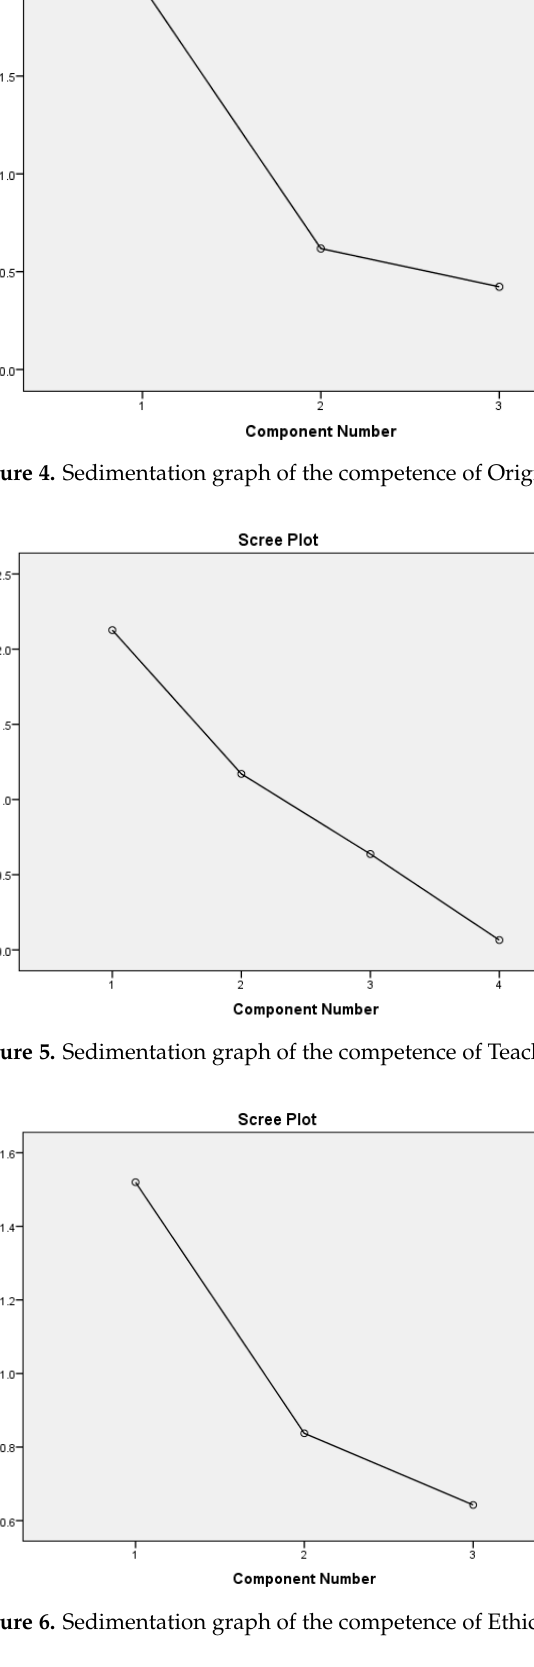
Figure 6. Sedimentation graph of the competence of Ethics and Citizenship. Source: Authors.